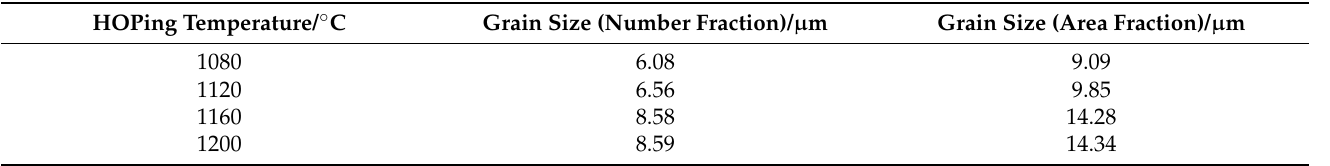
Table 2. The average grain size of the samples with various HOPing temperatures. HOPing Temperature/ ◦ C